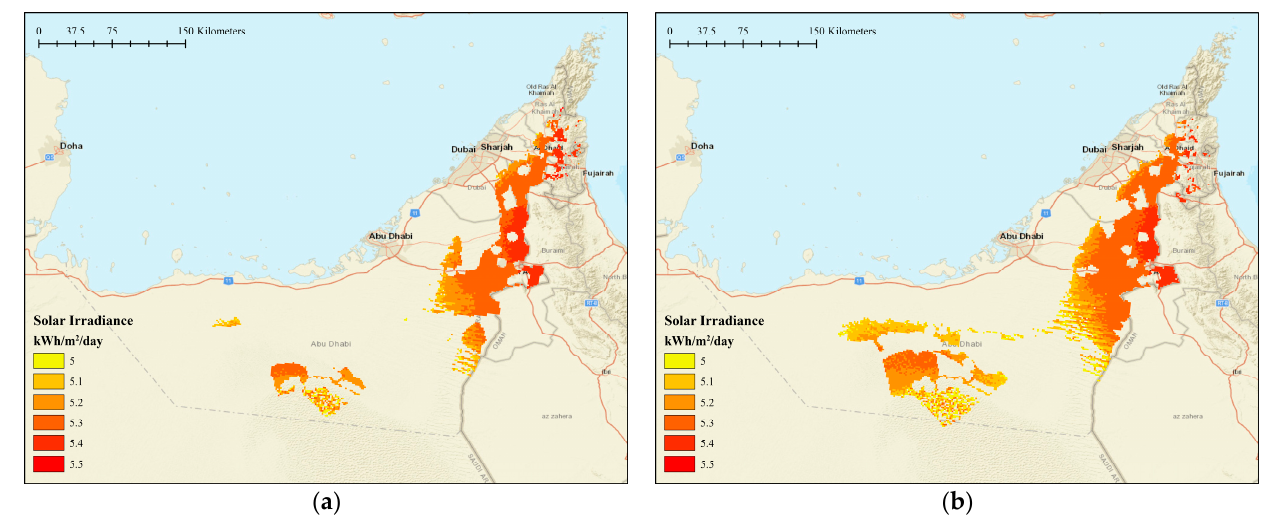
Figure 1. Areas with high solar potential in the UAE ( a ) 25 km and ( b ) 40 km from roads, electrical grid, and water areas.